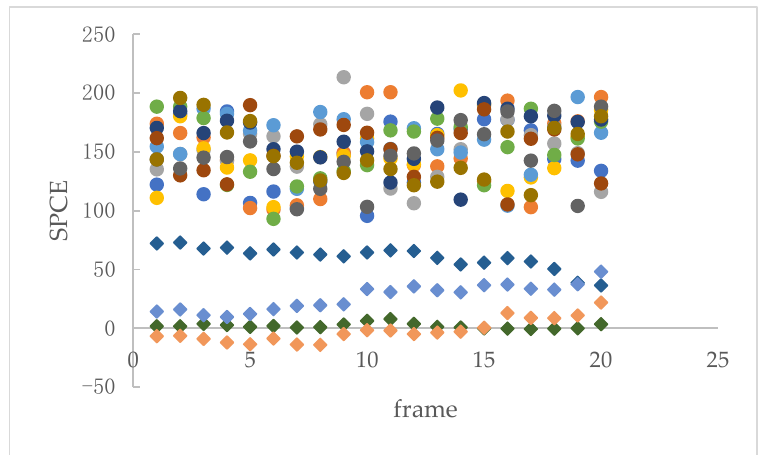
Figure 8. Distribution of SPCE values in moving objects. The circular symbols represent the SPCE values of the area where the car is located, and the diamond symbols indicate the SPCE values of the area where the cat is located. The horizontal axis represents the frame of the video, while the vertical axis represents the value of SPCE. A total of 20 frames of video were analyzed, in which cars were divided into ten zones represented by circular symbols of different colors, and cats were divided into four zones represented by diamond symbols of different colors.